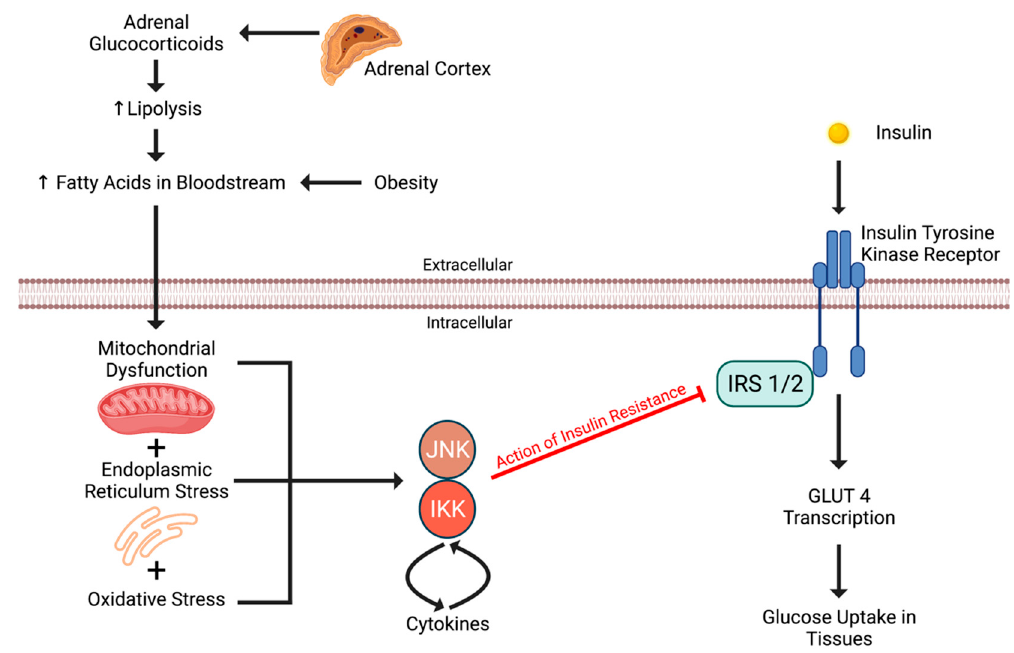
Figure 5. Adrenal glucocorticoids secreted from the zona fasciculata of the adrenal cortex induce lipolysis resulting in elevated fatty acids in the bloodstream. These fatty acids cause downstream inhibition of insulin receptor substrates 1 and 2 (IRS 1 and 2). This inhibition is critical in the development of insulin resistance. Figure created using